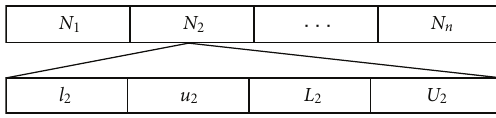
Figure 4: Data structure of normative knowledge.